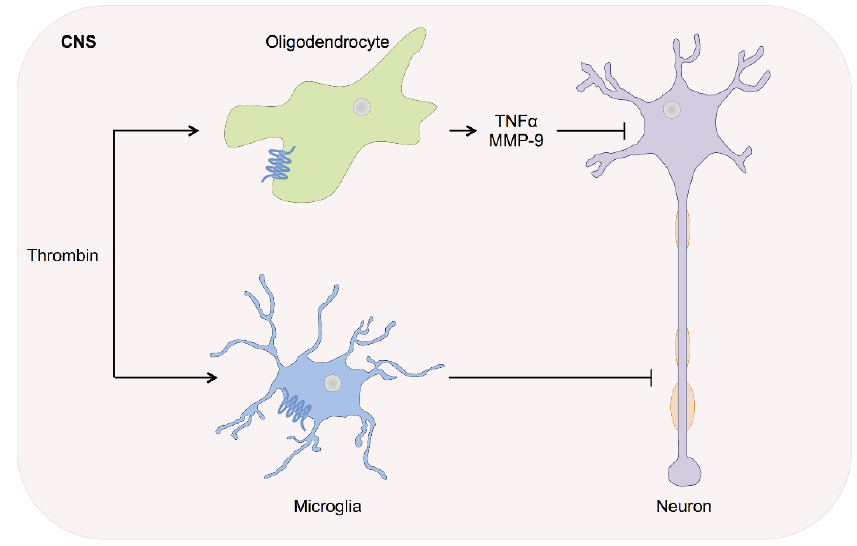
Figure 3. Multiple sclerosis. In MS fibrin deposits are related to axonal damage and demyelination. Thrombin-dependent PAR-1 activation on oligodendrocytes mediates the release of proinflammatory factors such as TNF- α or matrix metalloproteinase-9 (MMP-9). Furthermore, increased thrombin activity in the spinal cord was associated with increased microglia activation and neuronal demyelination, which correlate with a disease progression and neurological